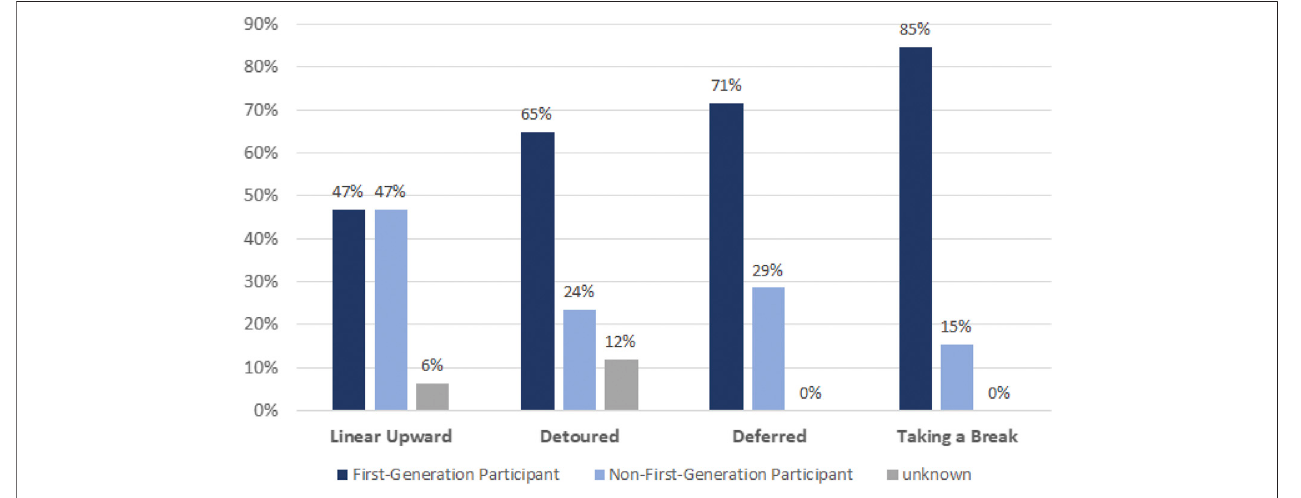
FIGURE 3 | Percentage of program participants on the four momentum trajectories by fi rst-generation